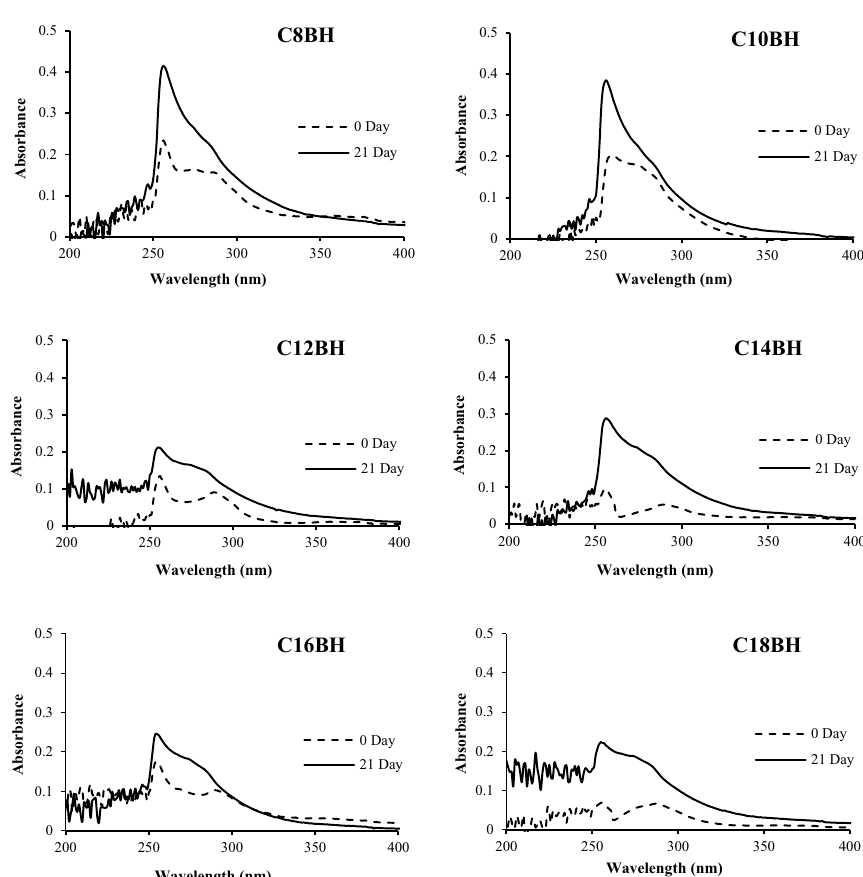
Fig. 4 UV absorbance spectrum (λ max : 256 nm) of bleached hair treated with six fatty acid hair treatments before (0 day) and after 21 days of application